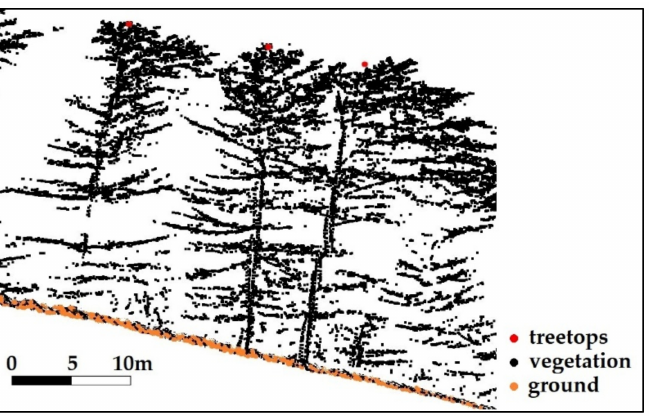
Figure 2. Treetops of reference trees marked red in the profile section of forest